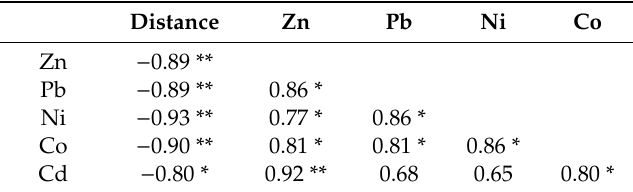
Table 2. Pearson’s correlation coe ffi cients ( r ) between contents of potentially toxic elements in moss